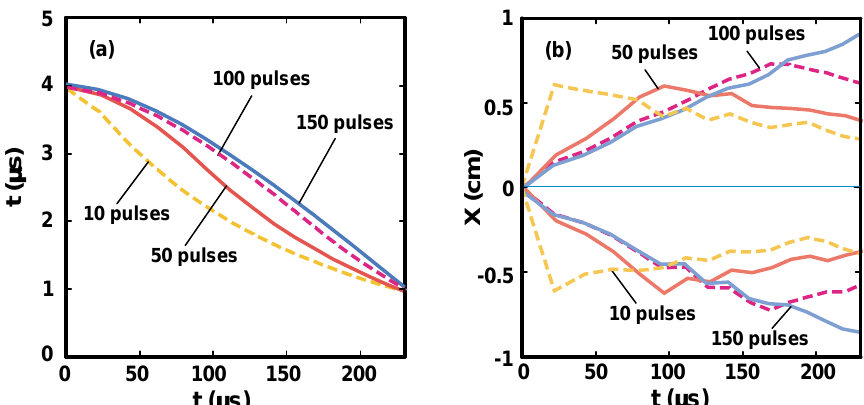
FIG. 6. (Color) (a) Beam duration and (b) the head and tail centroid displacement over 15 laps for compression schedules using ten cells per lap and trapezoidal waveforms for the first 10, 50, 100, and 150 pulses. The voltage variation in the trapezoidal pulses has been adjusted to give the same final compression.